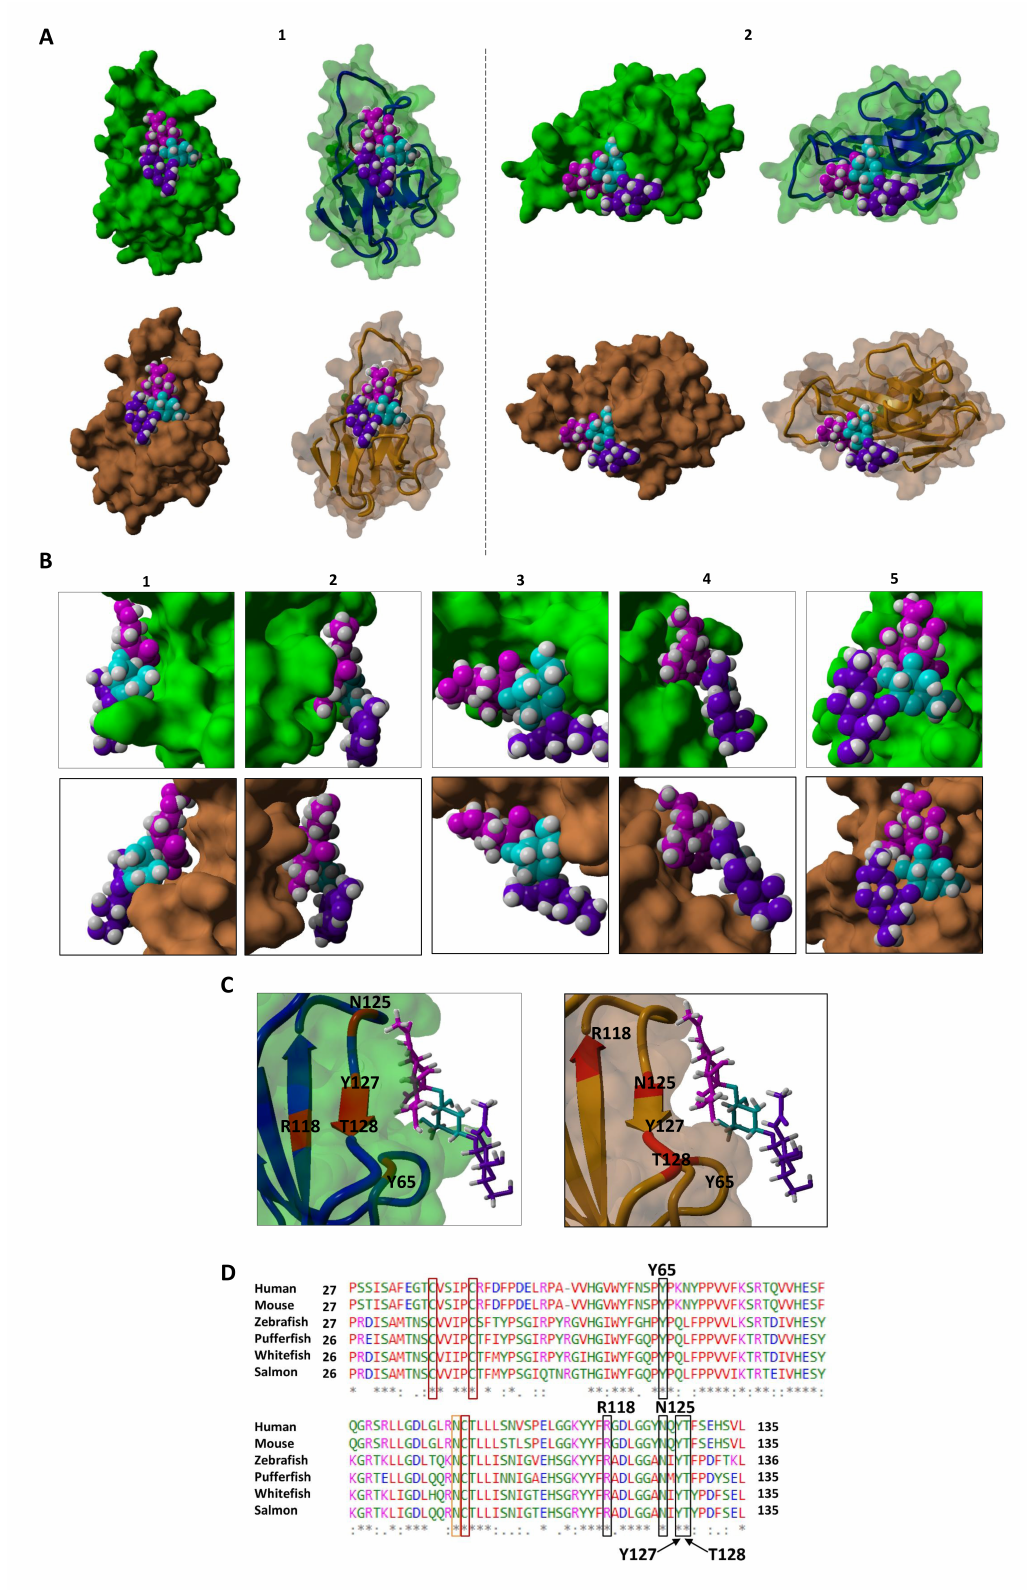
Figure6. SequenceandstructuralcomparisonofMAGfrommouseandmaraenawhitefish. ( A )YASARA was used to model the 3D structure of the sialic-acid-binding domain (V-set, Ig-like domain) of MAG from mouse and maraena whitefish. Based on the sequence alignments performed, the sequence of the murine MAG was shortened to the first Ig domain. The sequence of the V-set Ig-like domain of